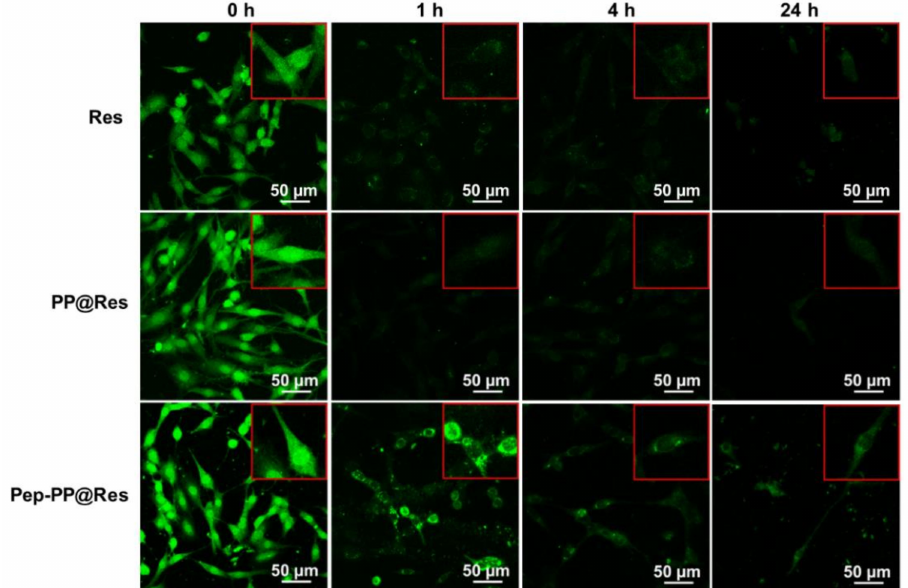
Figure 6. Distribution pattern and different intracellular retention times of the three Res formulations. Scale bars, 50 µ m in the main images and 100 µ m in the